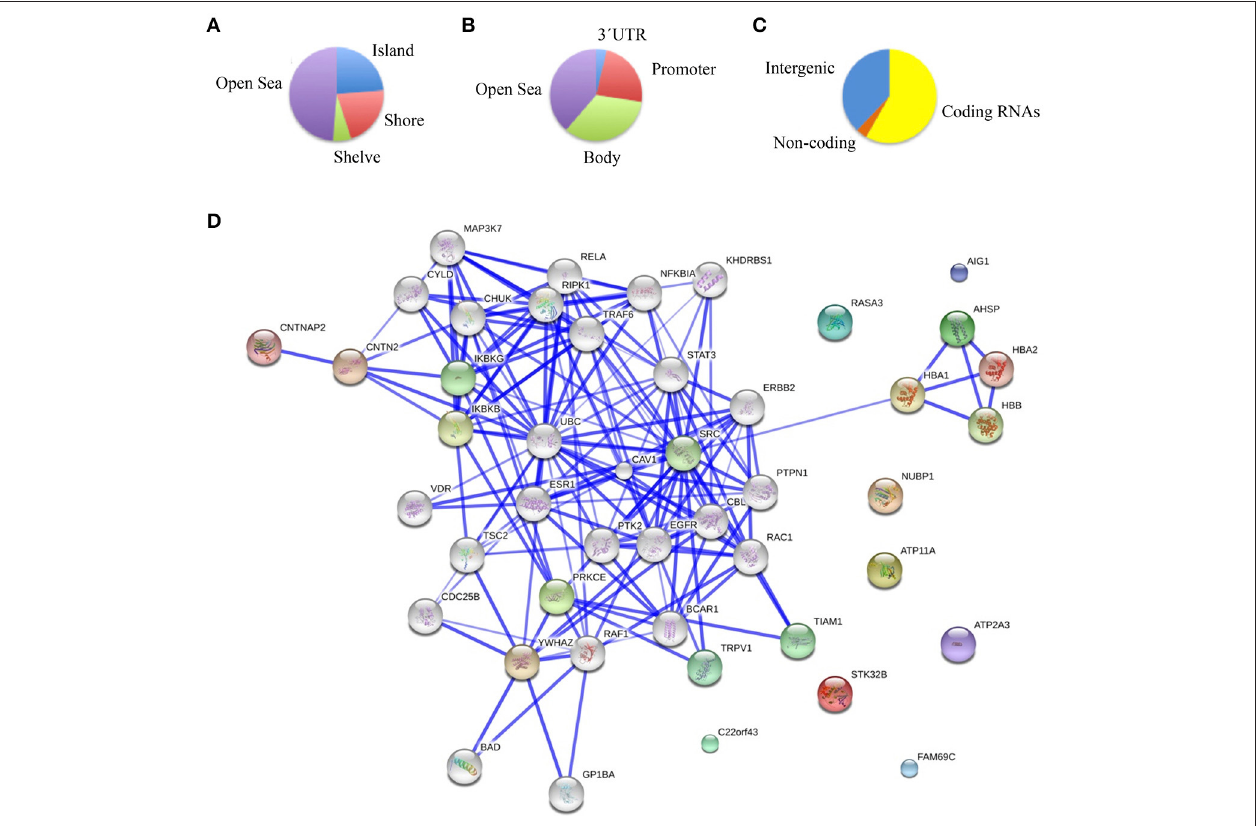
FIGURE 2 | (A) Functional genomic distribution, (B) CpG content and neighborhood context, and (C) associated RNA transcripts of the 66 differentially methylated CpGs between schizophrenic and healthy samples in the DLPC; (D) Network analysis using STRING (V9.05) identified different protein-protein associations. Stronger associations are represented by thicker